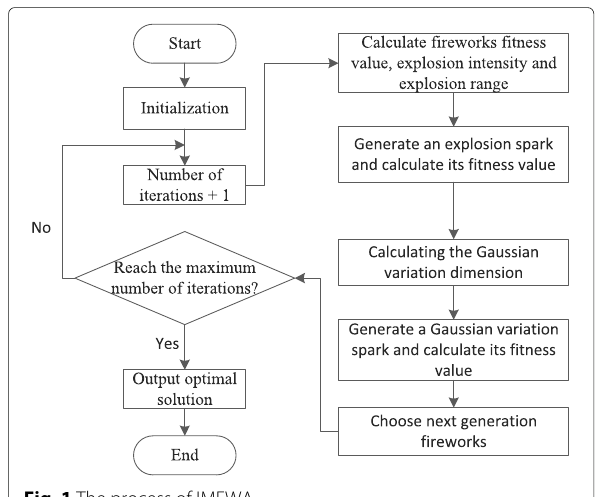
Fig. 1 The process of IMFWA